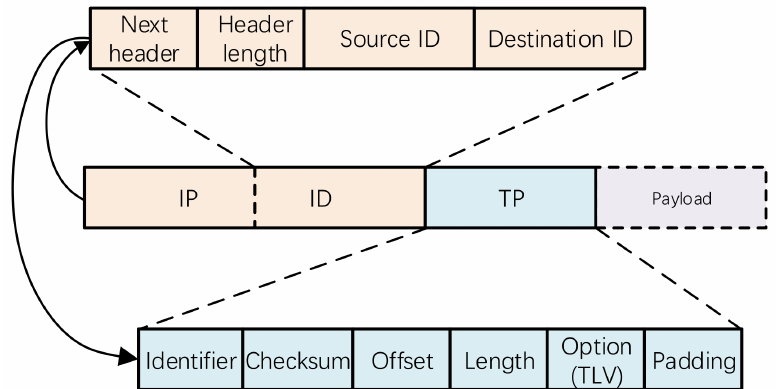
Figure 3. The packet format of ICN